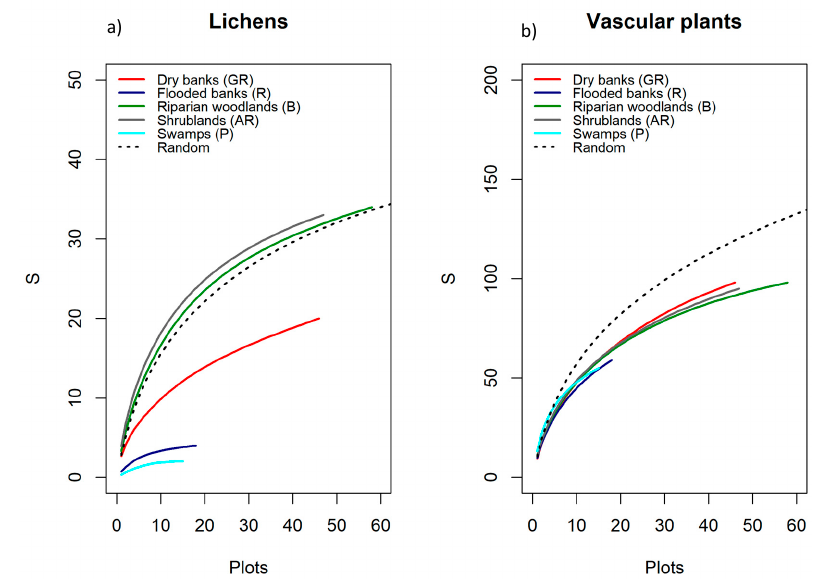
Figure 2. ( a , b ) Plot-based rarefaction curves calculated for lichens ( a ) and vascular plants ( b ), recorded from 184 plots sampled along the Tiber river for each riparian vegetation habitat vegetation types, showing the expected number of species, S, as a function of the number of plots. The plot-based rarefaction curve for the pooled sample of all the 184 plots is also shown (dashed line).